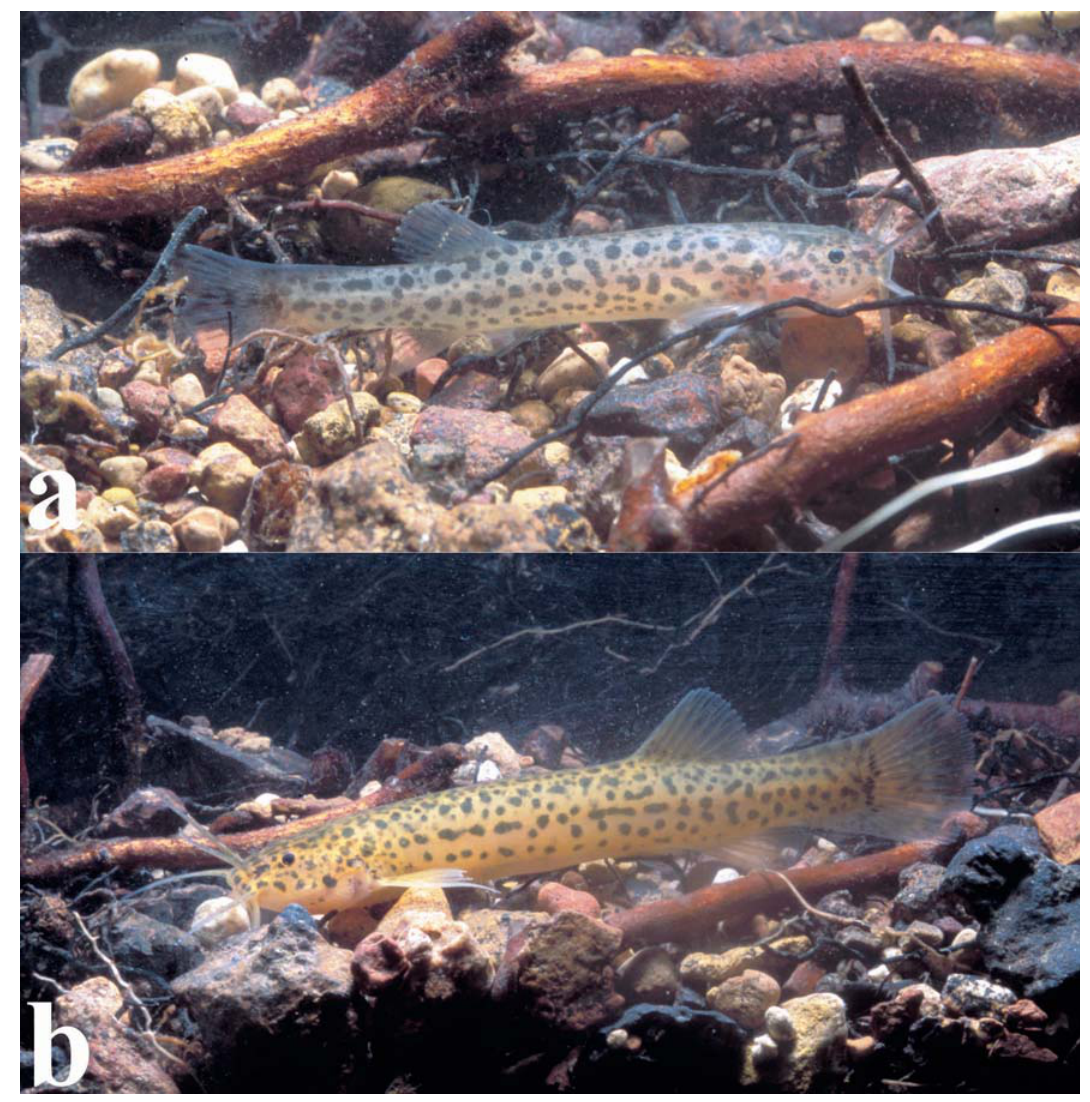
Fig. 3. Trichomycterus maracaya , n. sp. (ZUEC 6136), paratypes photographed in field aquarium shortly after collection. a , juvenile 24.1 mm SL; b , presumed adult 45.6 mm